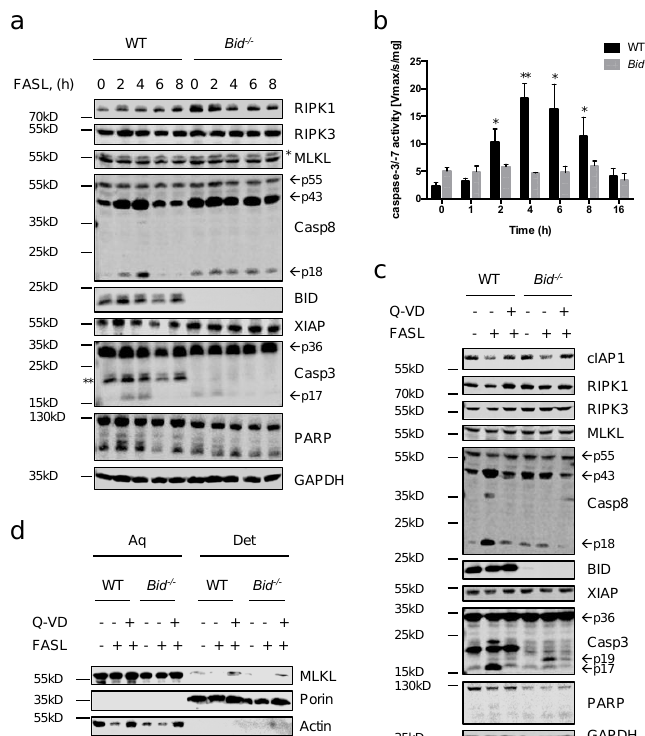
Figure 2. FASL induces apoptosis in neutrophils, which switches to necroptosis when caspases are inhibited. ( a ) WT and Bid − / − neutrophils were treated with FASL (100 ng/mL) for 0–8 h. Lysates were assessed by immunoblotting. Presented immunoblots are representative of at least two independent experiments. * indicates non-specific bands; ** indicates bands derived from previous anti-BID immunoblotting. ( b ) WT and Bid − / − neutrophils were stimulated with FASL (100 ng/mL) for indicated time points. Lysates were assayed for caspase-3/-7 activity by fluorogenic DEVDase assay. n ≥ 3, mean ± SEM. p < 0.05 (*), p < 0.01 (**). ( c ) WT and Bid − / − neutrophils were pre-treated with Q-VD-OPh (20 µ M) for 30 min and subsequently treated with FASL (100 ng/mL) for 6 h. Lysates were subjected to immunoblotting. Presented immunoblots are representative of at least two independent experiments. ( d ) WT and Bid − / − neutrophils were pre-stimulated with Q-VD-OPh (20 µ M) for 30 min followed by administration of FASL (100 ng/mL) for 16 h. Fractionation by phase separation was performed and lysates were subjected to immunoblotting. Presented immunoblots are representative of at least two independent experiments. All experiments were performed with in vitro differentiated